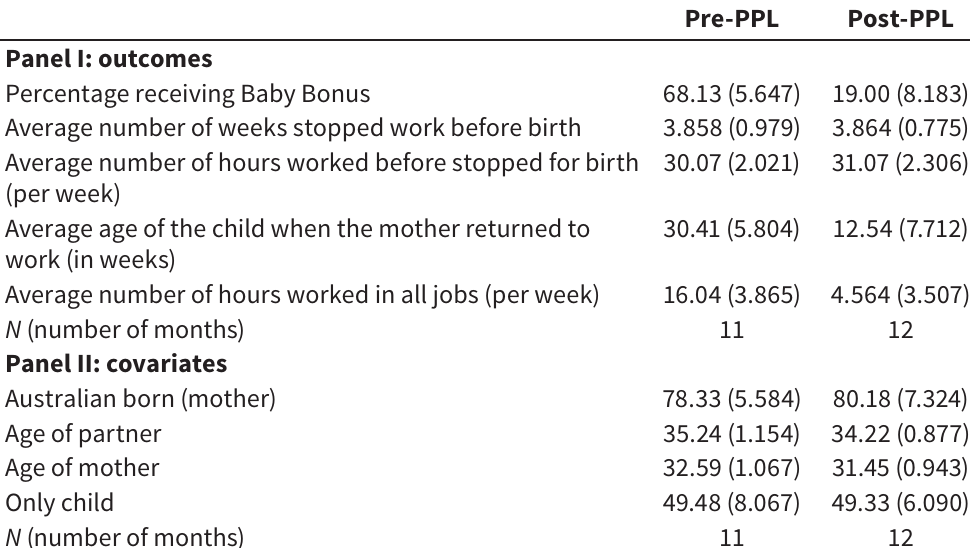
Descriptive statistics of analysis